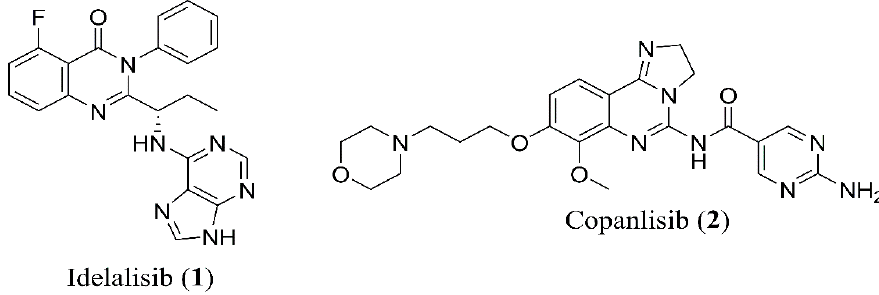
Figure 1. Chemical structure of PI3K inhibitor drugs idelalisib ( 1 ) and copanlisib ( 2 ).